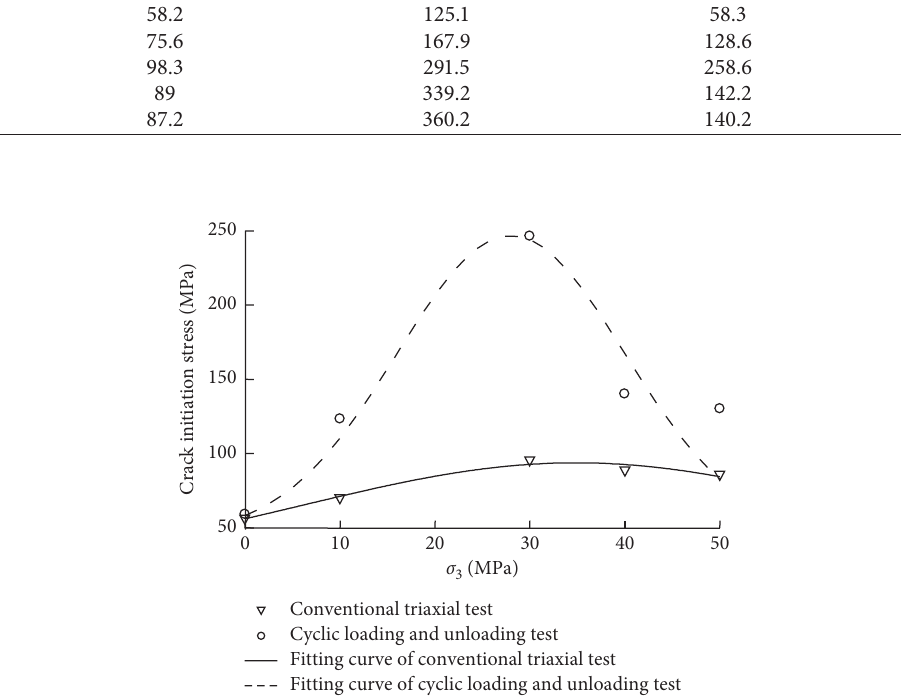
Figure 7: Relationship between crack initiation stress, crack damage stress, and confining